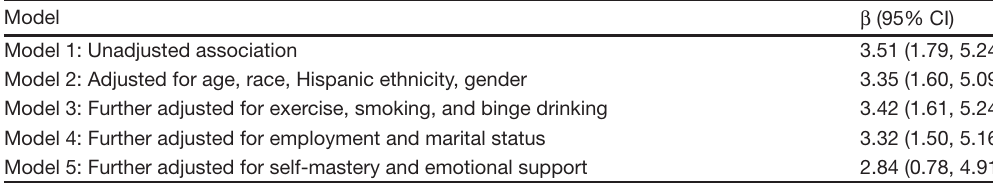
Table 3. Differences in anxiety ( β ) with direct contact with oil in communities participating in the GSPS